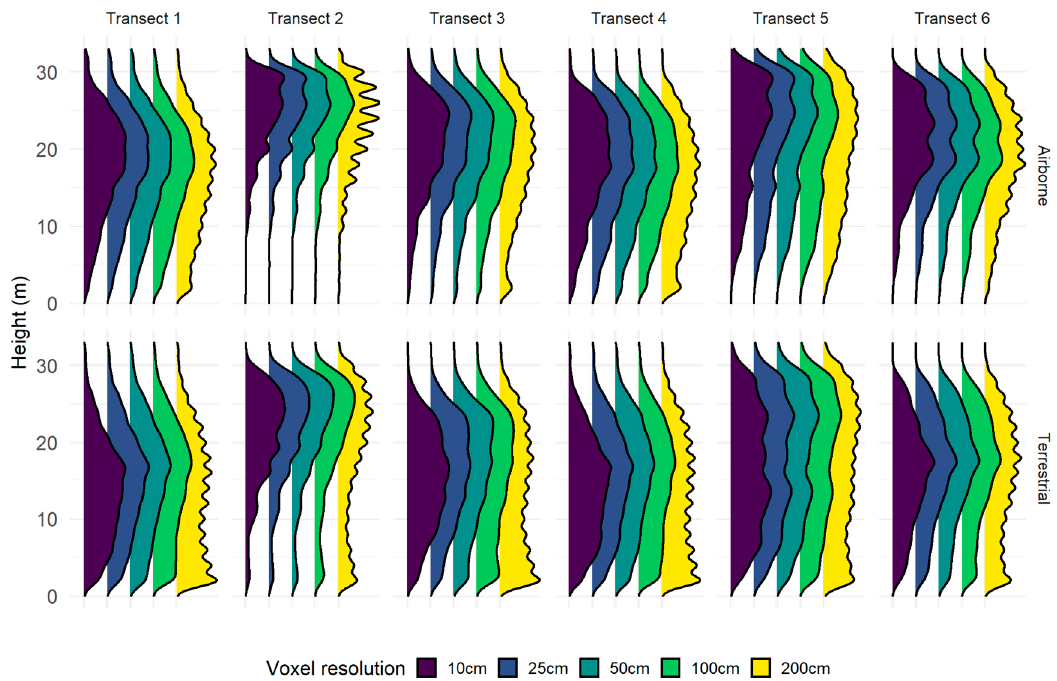
Figure 4. Probability distributions of LiDAR returns as a function of height for each transect and each platform calculated from the voxelized point-cloud data.